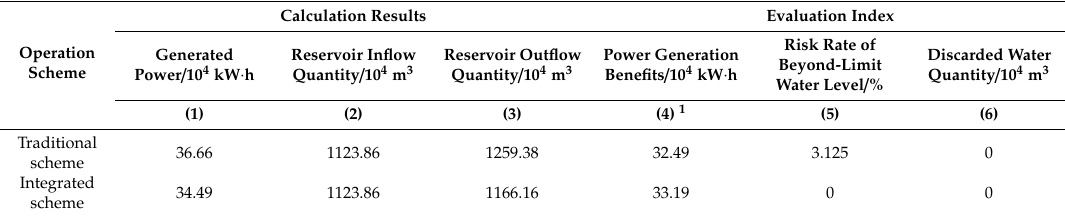
Table 4. Calculation results of the 3rd operating condition.